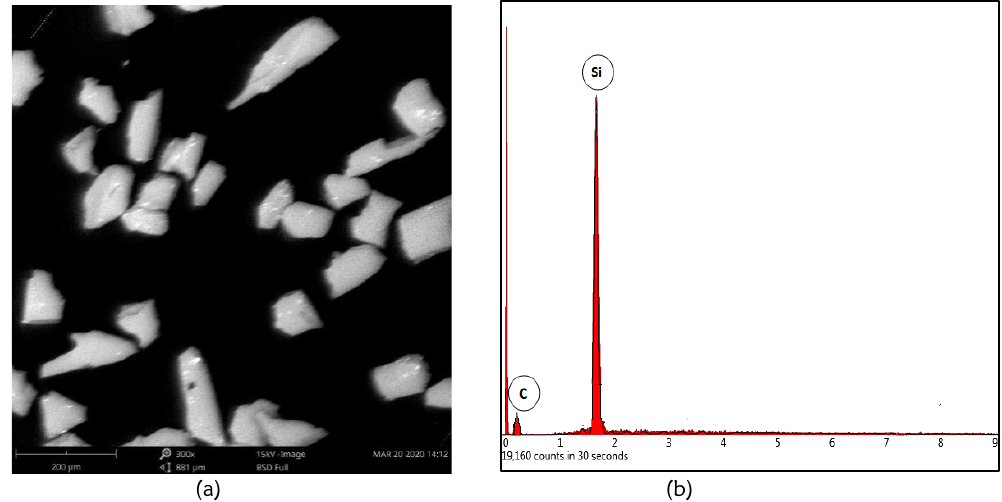
Figure 3: (a) SEM micrograph and (b) EDS of as-received 76 µm SiC p